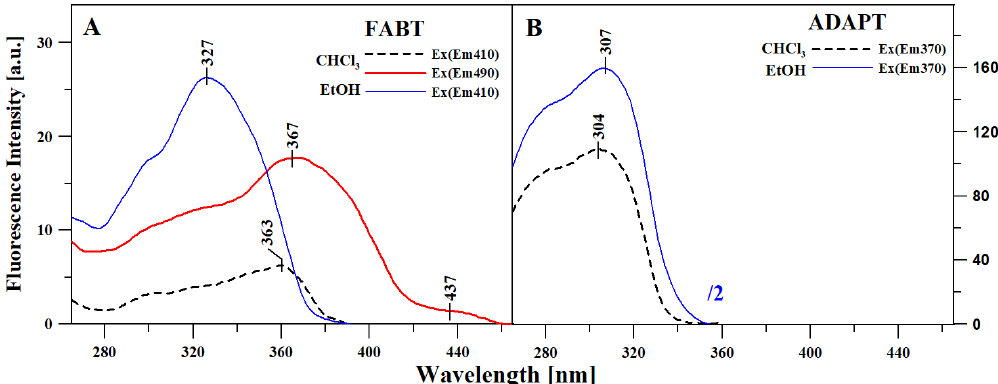
Figure 3. Fluorescence excitation spectra for FABT (Panel ( A )) and ADAPT (Panel ( B )) in the same selection of solvents as in Figures 1 and 2. For FABT (Panel A), emission was registered for the wavelengths of, respectively: 410 nm for ethanol and at 410 and 490 for chloroform. In the case of ADAPT (Panel B), emission was registered for the wavelength of 370 nm in both solvents.